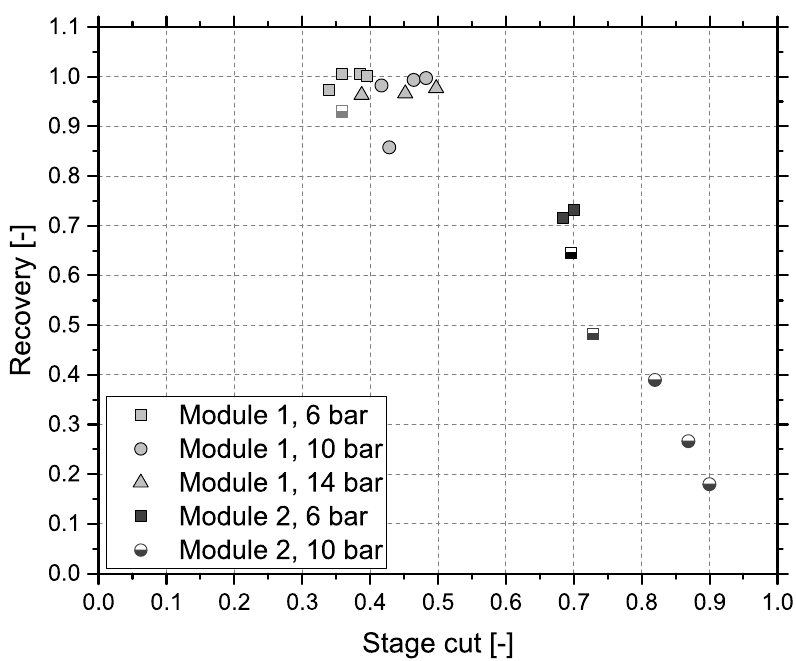
Figure 5. Recovery of CH 4 vs. stage cut for both modules; successful experiments ≥ 96 vol % CH 4 identified with semi-filled